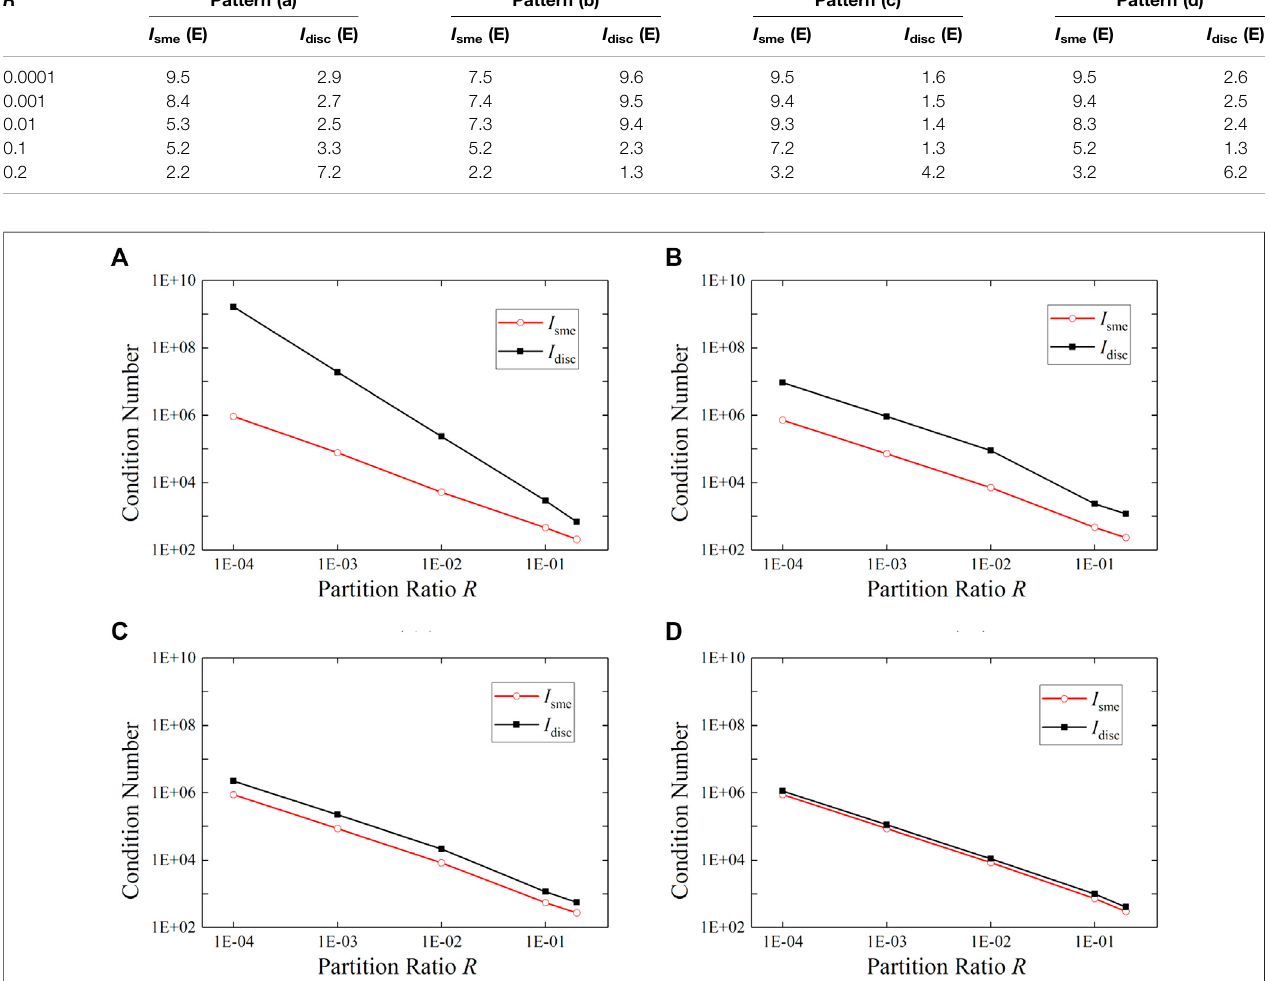
FIGURE 6 | Relationship curves of condition number with regard to partition ratio corresponding to four partition patterns (see Figure 5 ) obtained using two integration methods.